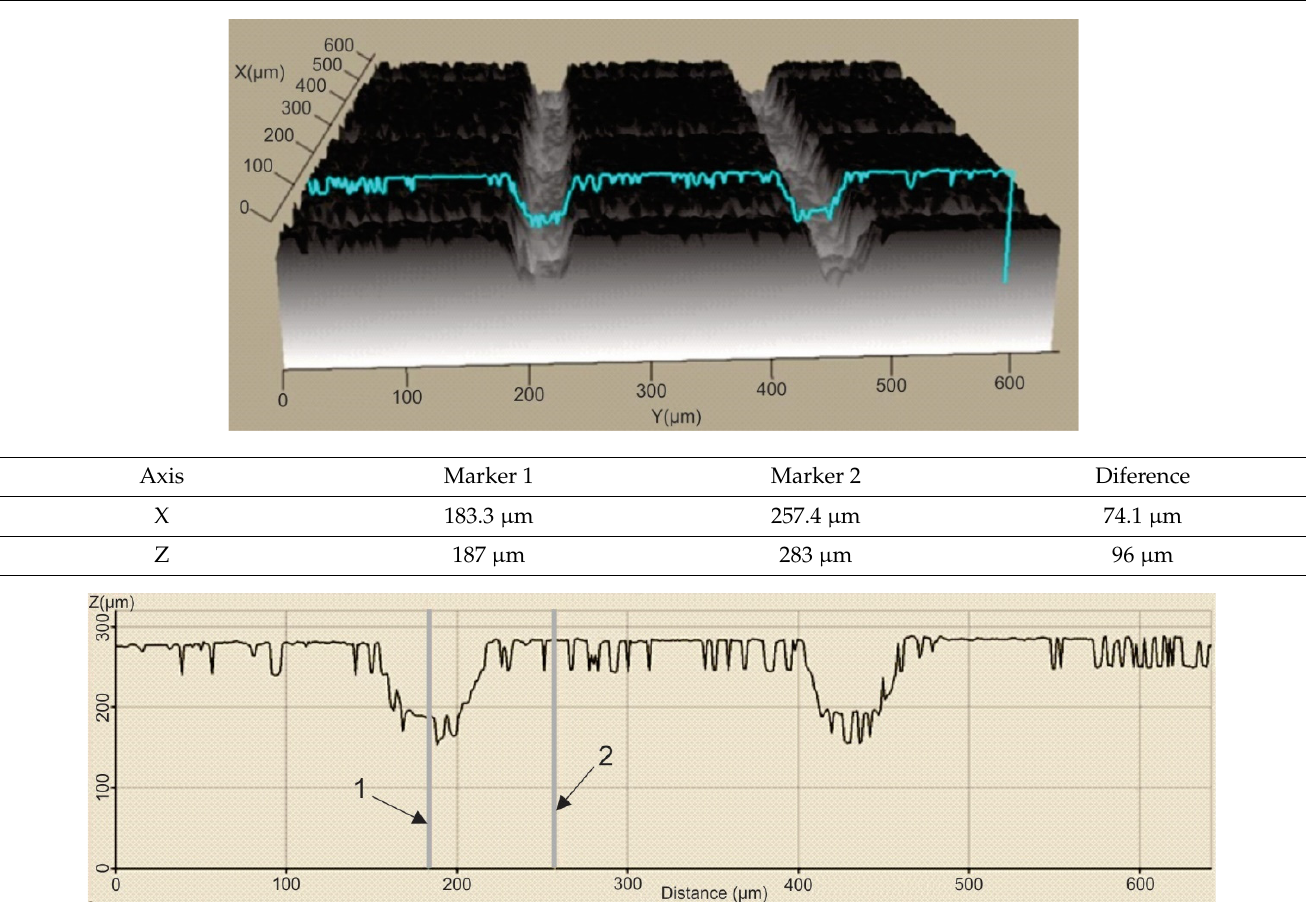
Table 4. Confocal microscopy 3D reconstruction and roughness diagram.